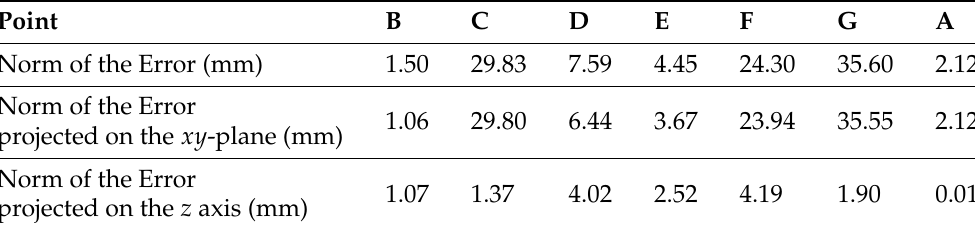
Table 7. Norm of the errors of the accuracy test performed on the joint model.